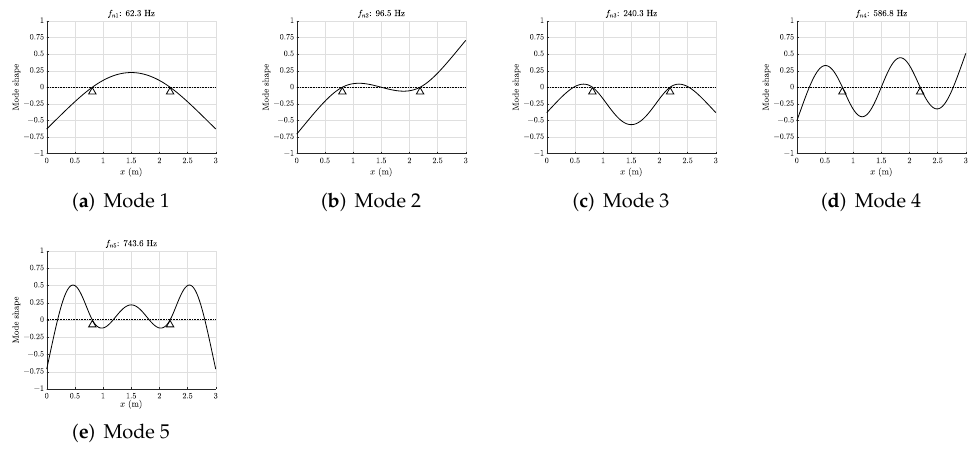
Figure 4. First five modes of vibration of the slat.